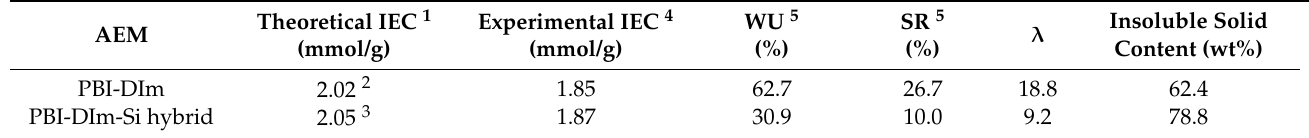
Table 1. Properties of the PBI-DIm and PBI-DIm-Si hybrid